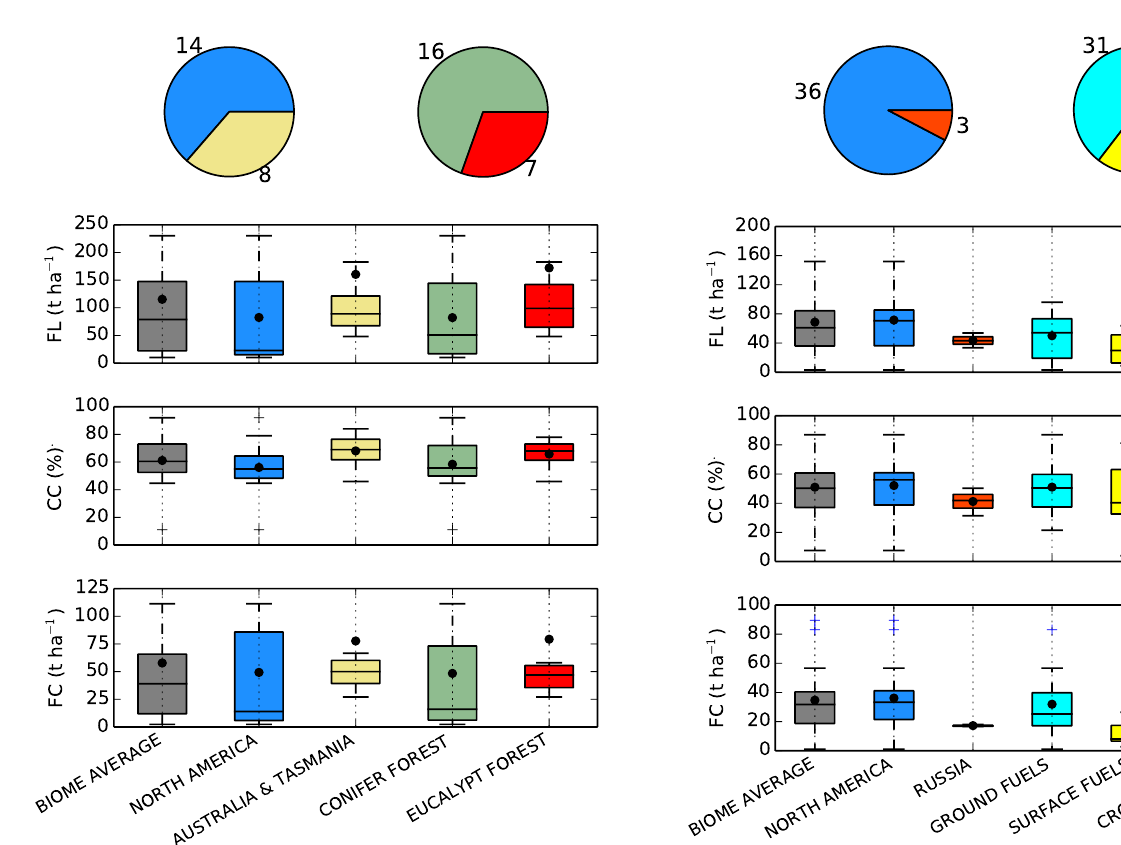
Figure 4. Overview of field measurements of fuel load (FL), com- bustion completeness (CC), and fuel consumption (FC) in the tem- perate forest biome. The pie charts on top correspond to the number of unique measurement locations for different geographical regions (left) and forest types (right), and in the box plots below field aver- ages of FL, CC, and FC are presented. The boxes extend from the lower to upper quartile values of the measurement data, with a line at the median and a black filled circle at the mean. The whiskers extend from the box to show the range of the data, and outliers are indicated with pluses.